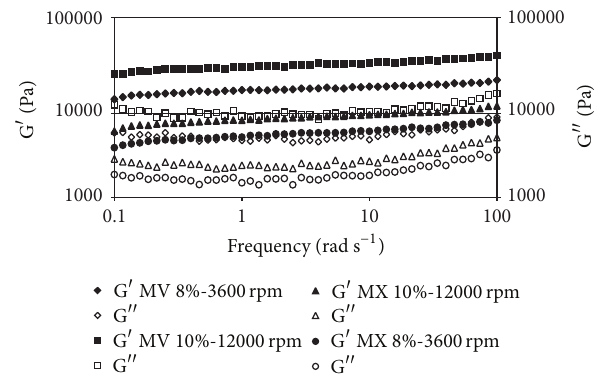
Figure 1: Frequency sweep comparison of canola oil samples. 𝐺 󸀠